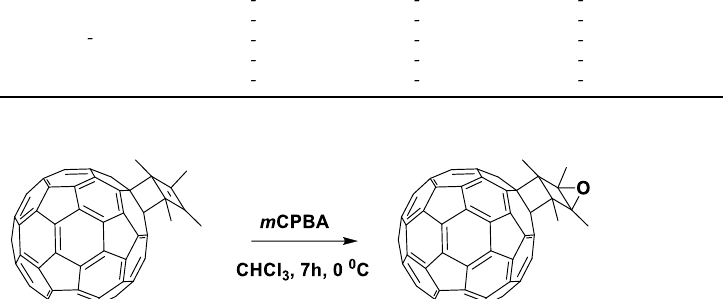
Figure 17. Molecular structures of the fullerene cycloadducts with reduced electron